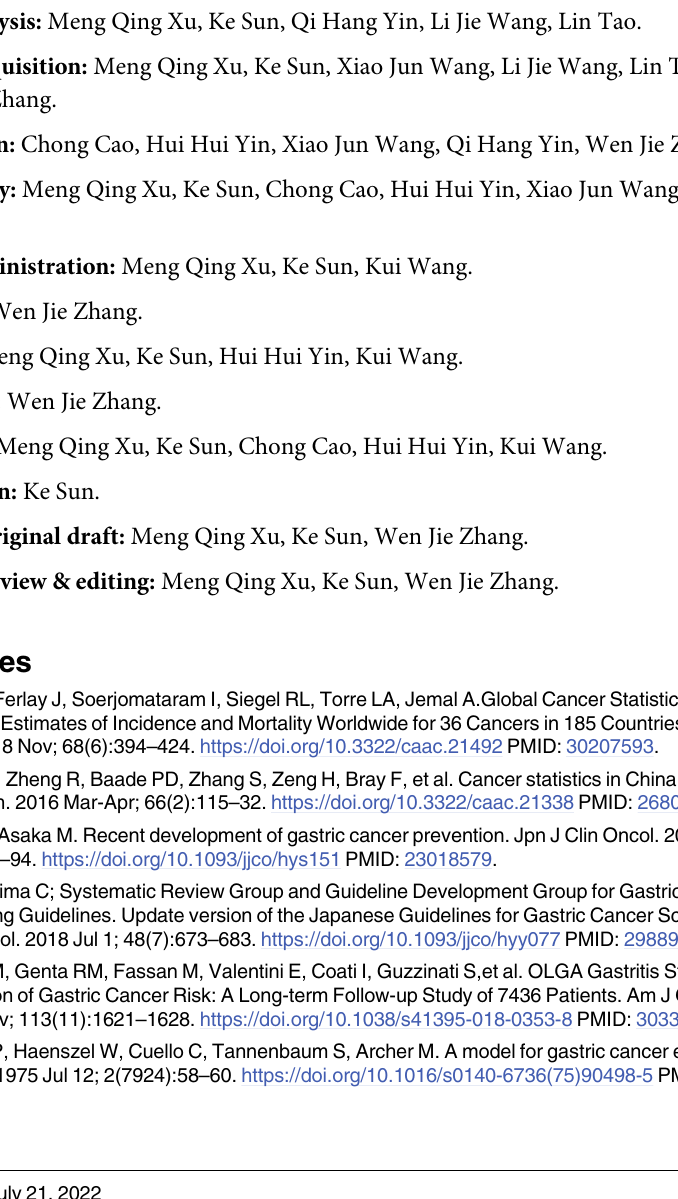
S2 Fig. Age distribution of patients in Hp infection and gastritis. (TIF) S3 Fig. Age distribution of patients in Hp infection, GIN and GC.